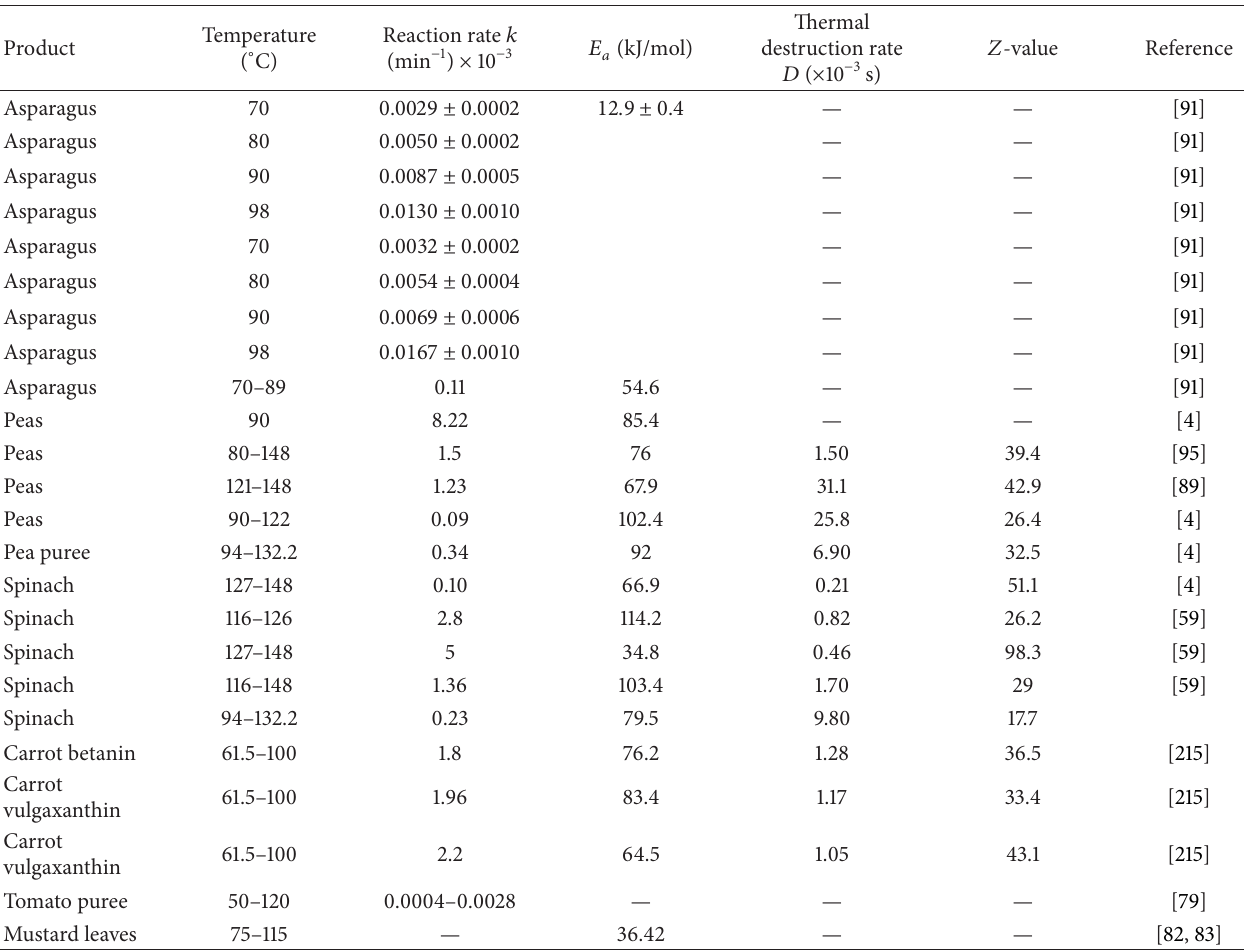
Table 7: Kinetic parameters associated with color degradation in